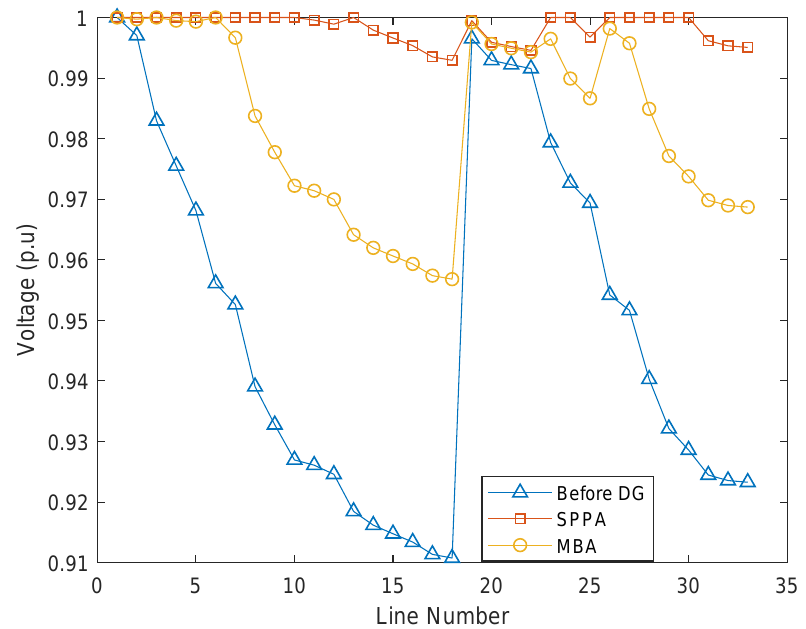
Figure 2. Bus voltage profile of NW-1. Active Power Losses have also been considerably decreased after the optimal siting and sizing of DG with SPPA. Cumulative active power loss for system without DGs is 208.45 kW, whereas after DG-Type 1 placement with MBA the cumulative active power loss is observed to be 64.34 kW. The active power loss is reduced to 63.74 kW for DG-Type 1 with the proposed method. The highest active losses occur at node number 27 which are 11.14 kW, 10.28 kW and 10.27 kW before DG placement, with MBA and with SPPA, respectively. The active power loss results are shown in Figure